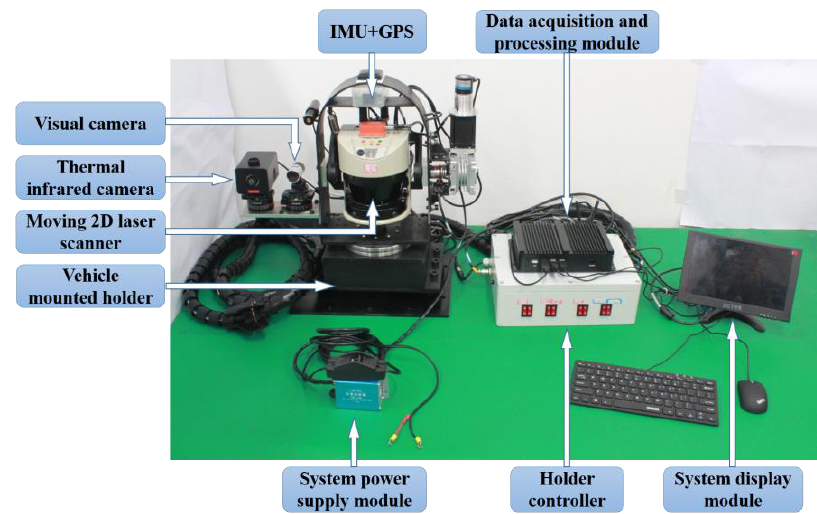
Figure 1. The AFM multi-sensor measuring system.